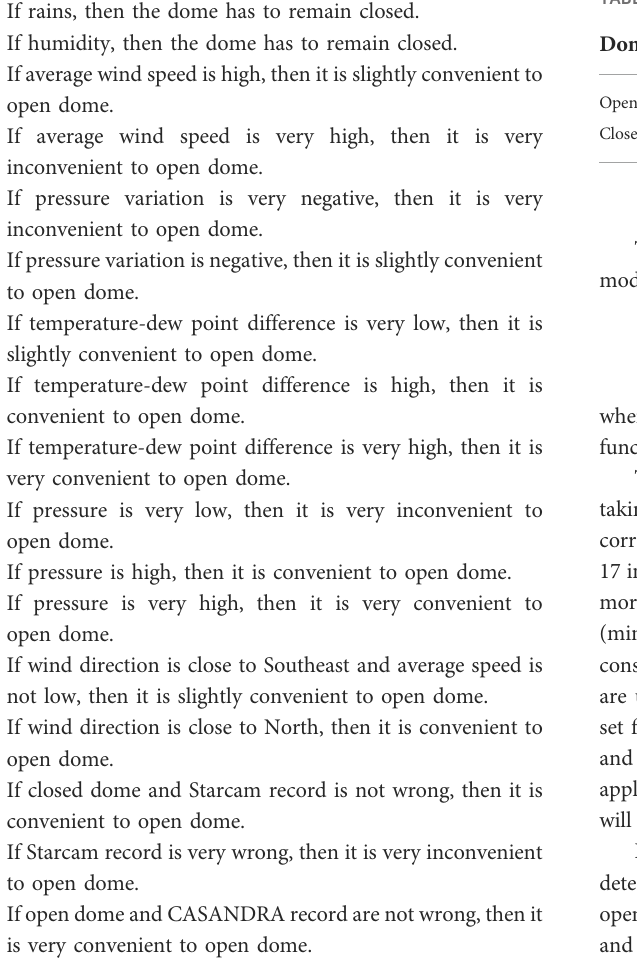
TABLE 5 Statistics of the degree of convenience of opening